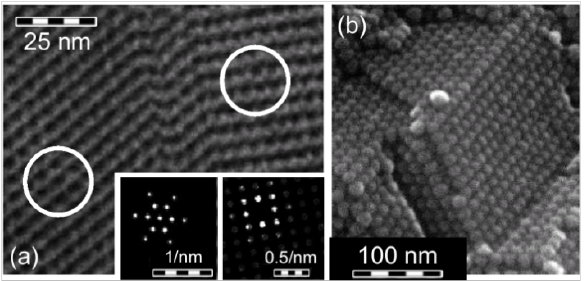
Figure 8: Self-assembled FeCo nanoparticles with different dimen- sions: (a) The 2D-monolayer of 4.6 nm sized spherical FeCo nanocrys- tals shows a phase transition from a hexagonal to a cubic lattice symmetry. The FFT patterns are taken from the marked areas. (b) SEM image of a millimetre sized 3D supercrystal composed of FeCo particles with a diameter of 15 nm. The crystal has been broken to show the high degree of order inside. (Figure (b): Reprinted by permis- sion from Macmillan Publishers Ltd: Nature Materials, ref. [48], copy- right 2005,